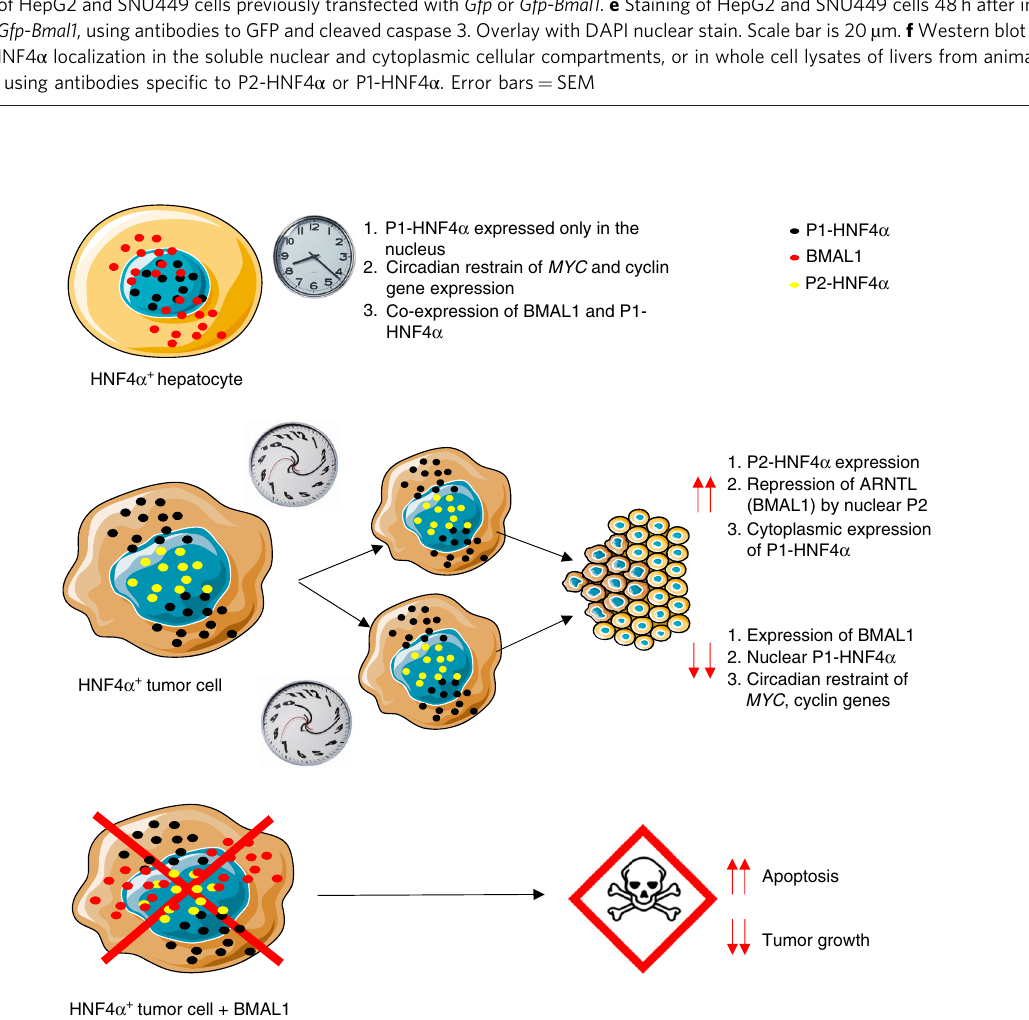
Fig. 6 BMAL1 overexpression in HNF4 α -positive HCC inhibits tumor growth a Luciferase assay results showing luciferase expression from BMAL1-LUC following transfection of DNA for the empty vector (EV), P1-Hnf4a or P2-Hnf4 α with or without co-expression of ROR α and with co-application